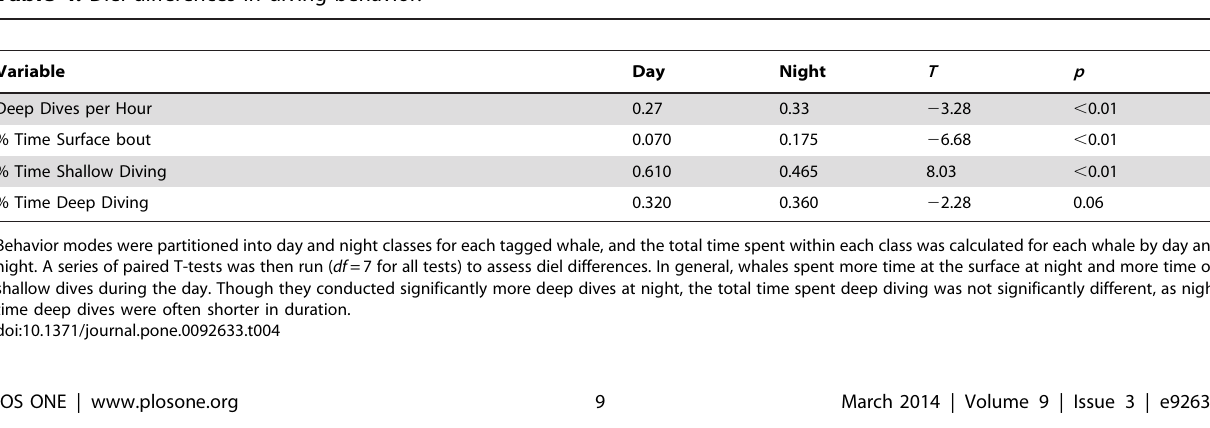
Table 4. Diel differences in diving